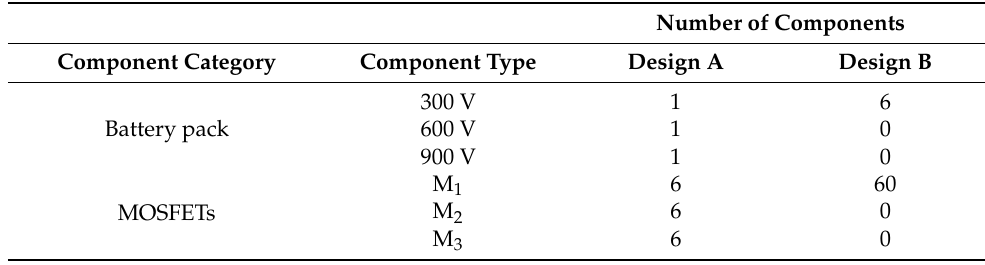
Table 3. Modularity evaluation. Component count to produce a set of three units (one unit of EV 1 plus one unit of EV 2 plus one unit of EV 3